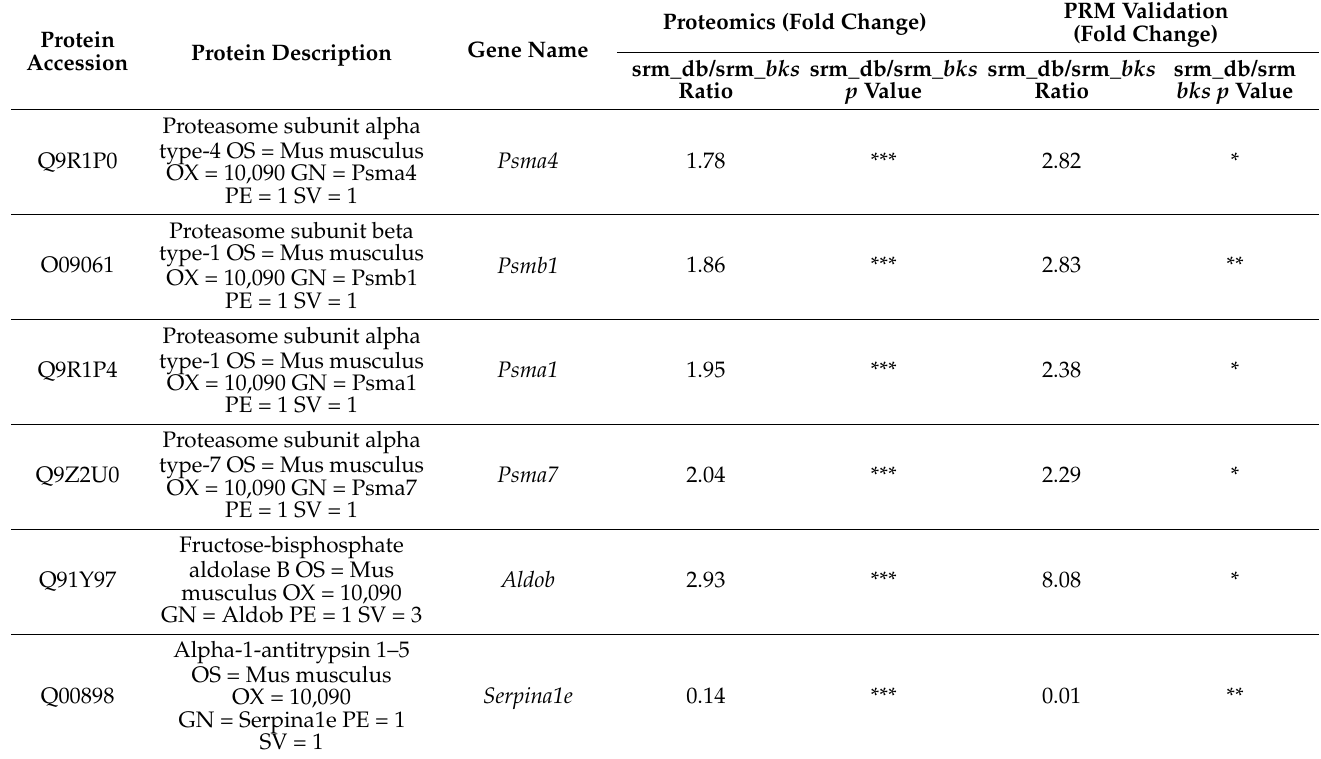
Table 2. DEPs generated by mice serum global proteomics validated by